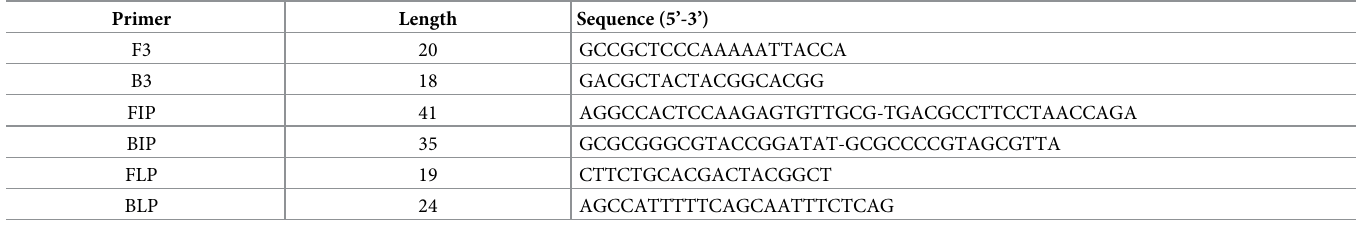
Table 2. Nucleotide sequences and sizes of established LAMP primers. Primer